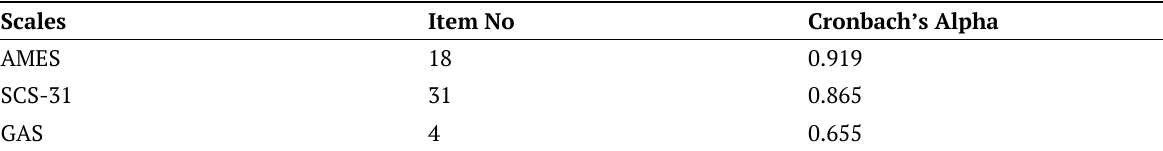
Table 2. Reliability Test